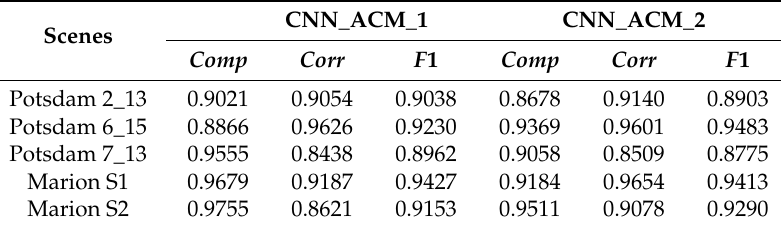
Table A4. Accuracies of the proposed method at the pixel